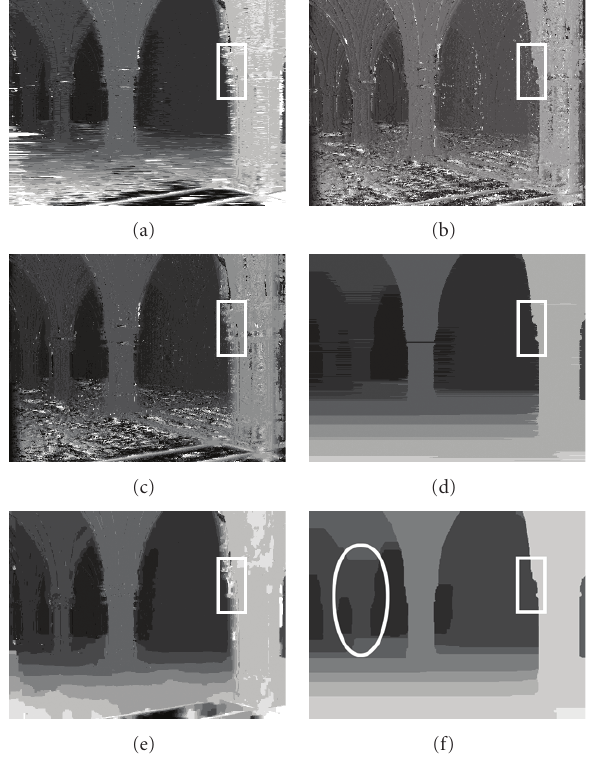
Figure 6: Disparity maps obtained using methods based on: correlation (a),(b), horizontal smooth constraint (c),(d), and 2D smooth constraint (e),(f). Images (a),(c),(e) and (b),(d),(f) are, respectively, computed without and with our occlusion approach.